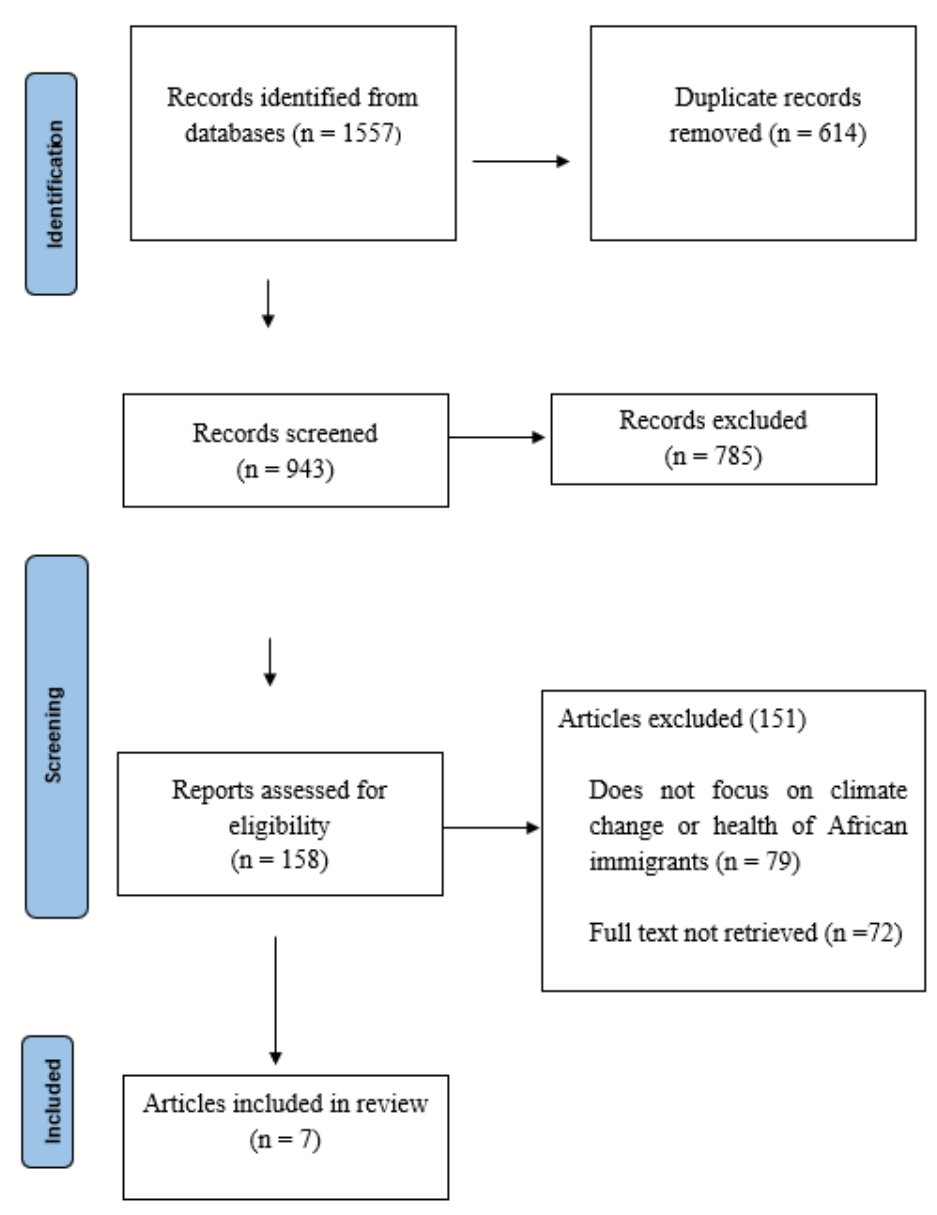
Figure 1. PRISMA flow diagram of article selection.